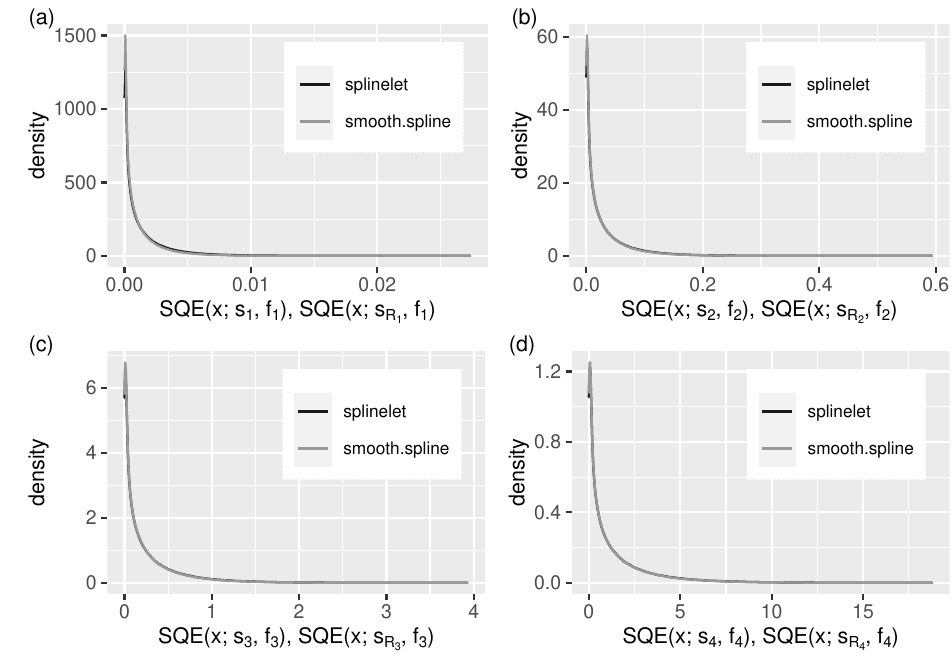
Figure 7. As in Figure 6, but for the squared approximation errors, SQE . ( a – d ) f 1 – f 4